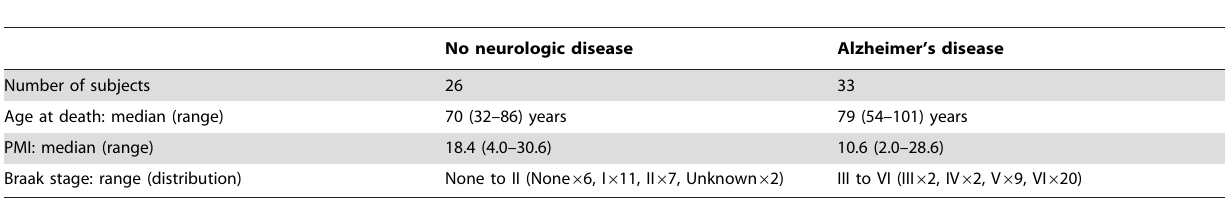
Table 1. Characteristics of female subjects without neurologic disease or with Alzheimer’s